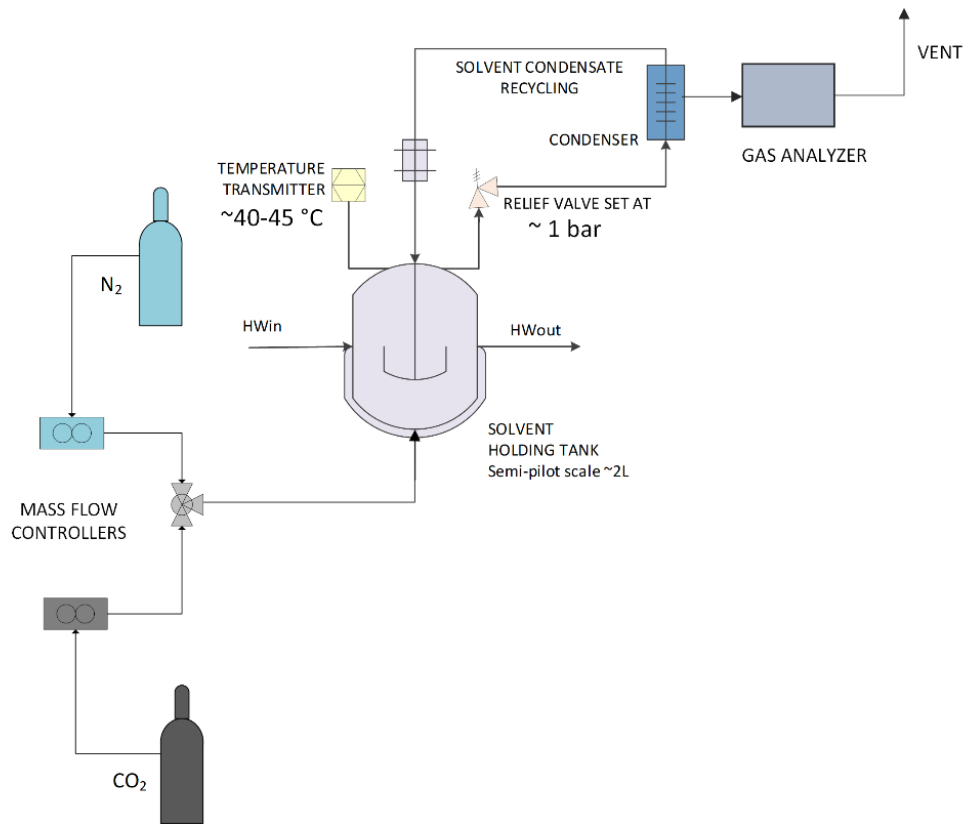
Figure 1. Schematic representation for the procedure followed to load with CO 2 the MEA solutions. A traditional three-electrode cell was used for all electrochemical tests. The reference electrode was a saturated calomel electrode (SCE), and the auxiliary (counter) electrode was a platinum rod. During the experiments, the unloaded and loaded MEA solutions were sealed in glass containers and kept at a constant temperature of 25 ◦ C, 40 ◦ C, and 80 ◦ C without using any purging gas.